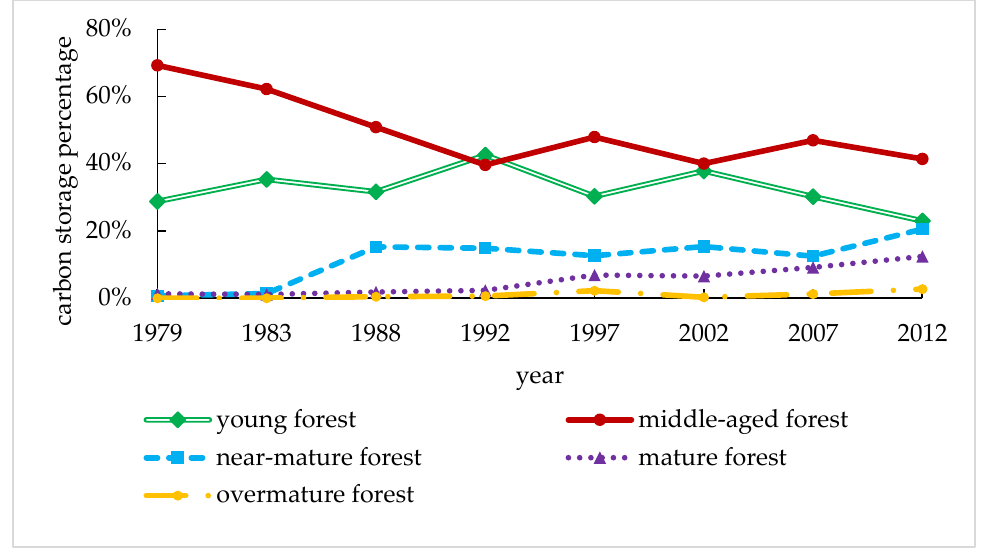
Figure 2. The changes of carbon storage percentage on age class of arbor forest.